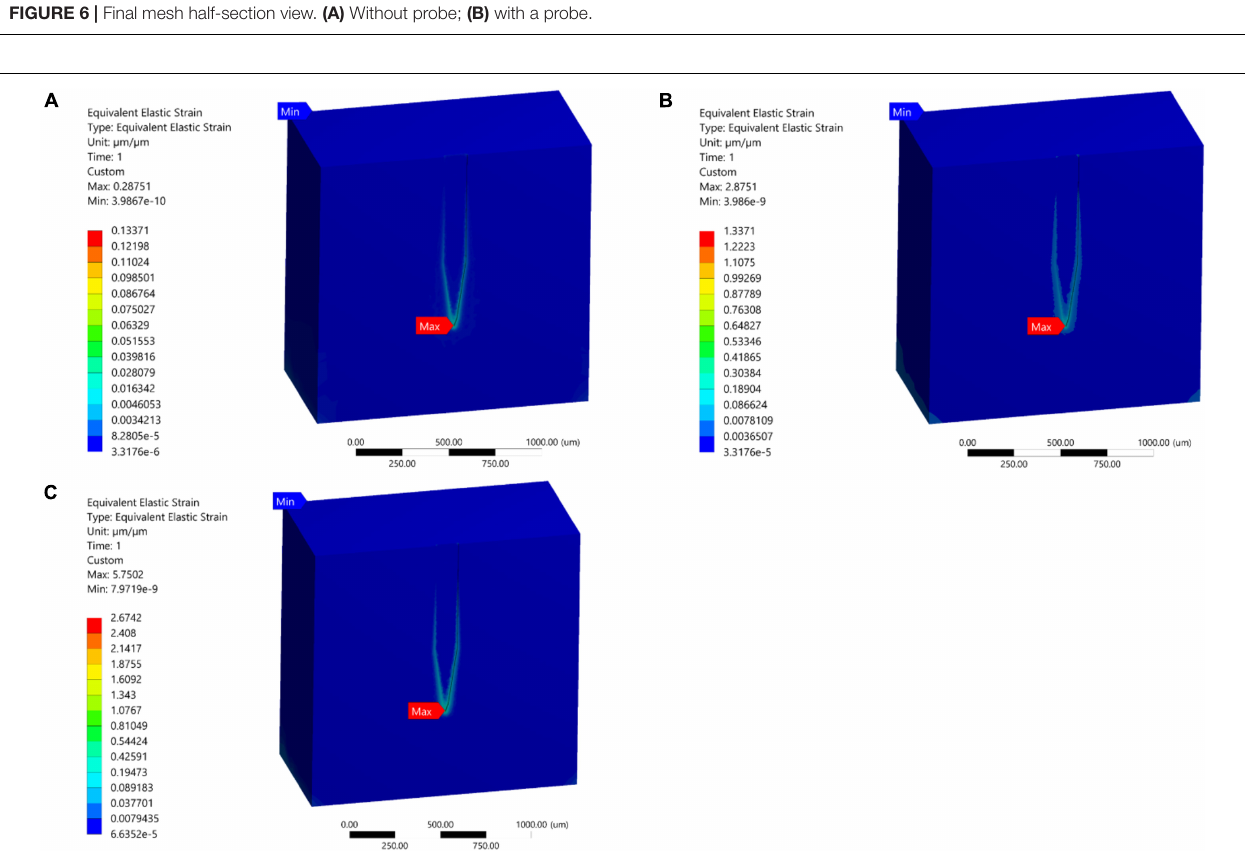
FIGURE 7 | Mid-section views of the strain distribution for the stiff Michigan probe. (A) 1 µ m – Case 1; (B) 10 µ m – Case 2; (C) 20 µ m – Case 3. The strain is concentrated at the tip of the probe and along the contact surfaces for the different loading conditions.